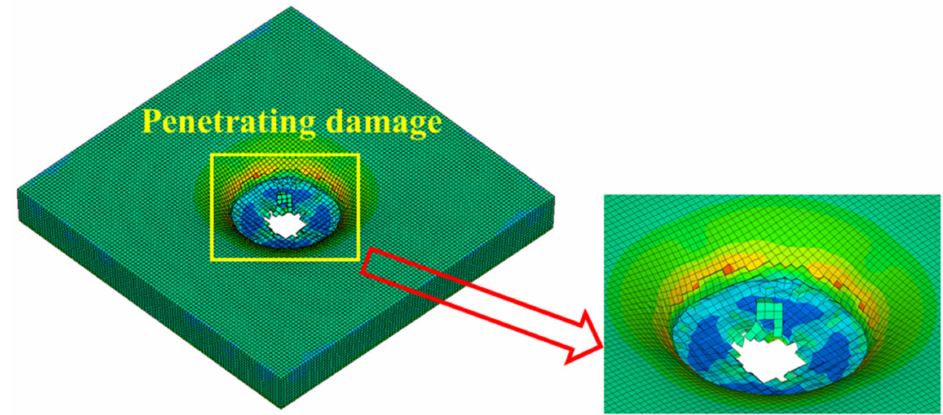
Figure 22. Failure states of polyurethane sacrificial cladding in the ALE coupling